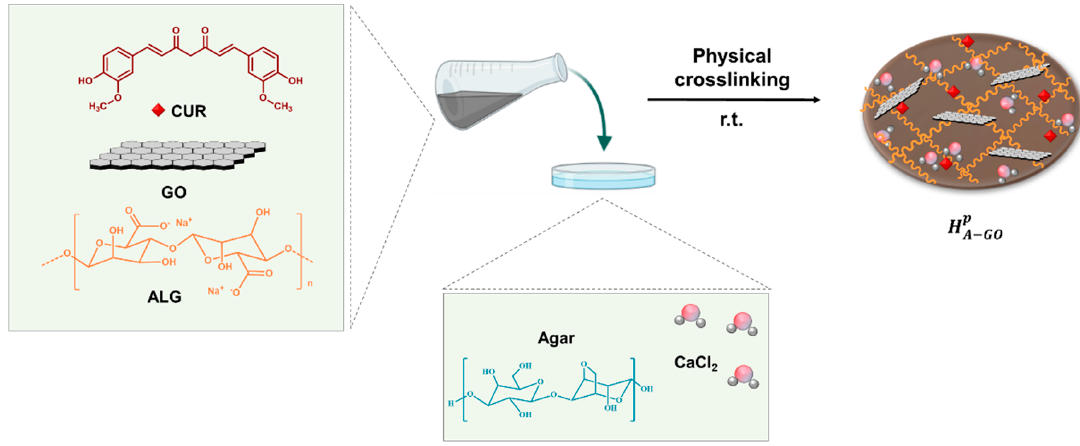
Figure 1. Schematic representation of the preparation of 𝐻 (cid:3002)(cid:2879)(cid:3008)(cid:3016)(cid:3017) hydrogels.